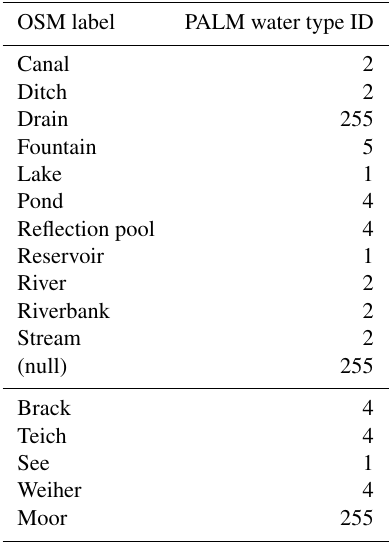
Table B9. OSM values to PALM water type. “255” is a fill value, assigned to non-water pixels.